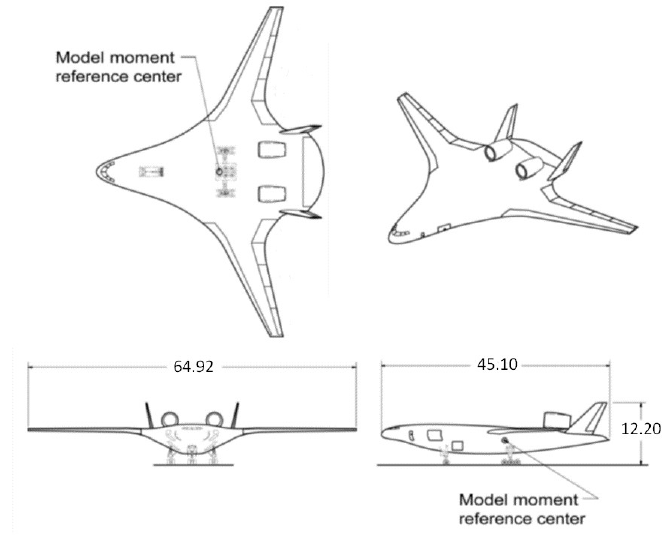
Figure 2. Three views drawing of N2A aircraft. Dimensions in metres.